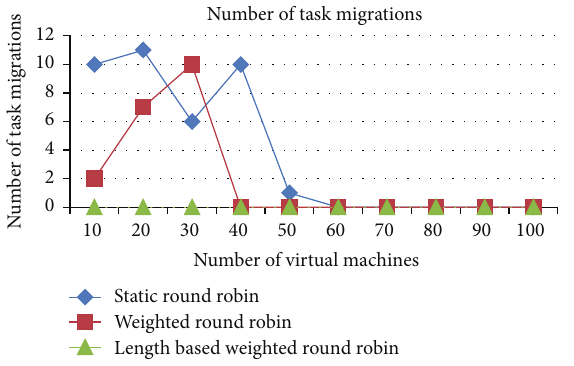
Figure 9: Idle time of all tasks (space shared).